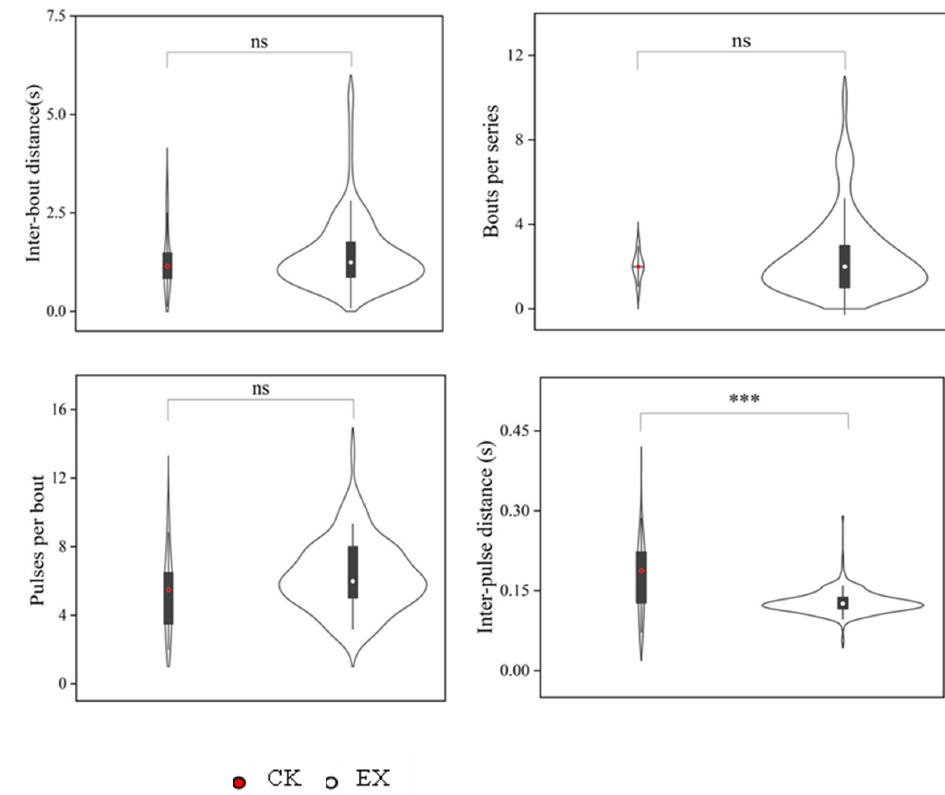
Figure 6. Comparison of the inter-bout time interval, bouts per series, pulses per bout, and inter-pulse time interval of the plateau zokor Seismic signal were compared between control and experimental situations. within the natural and artificial tunnels. In the violin plot, the lower and upper edges of the box represent the 25% (q1) and 75% (q3) quartiles, respectively. The dots inside the box represent the median (md). The whiskers extend to the most extreme values the dot inside the box, md ± 1.5 (q3 − q1). Note: *** p < 0.001; ns, non-significant. CK: natural tunnels; EX: artificial tunnels.